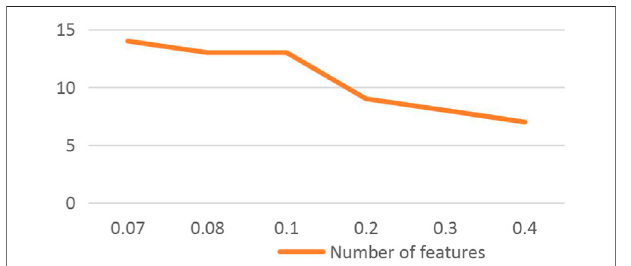
FIGURE 2 | Line chart of the classi fi cation accuracy of the data set on different